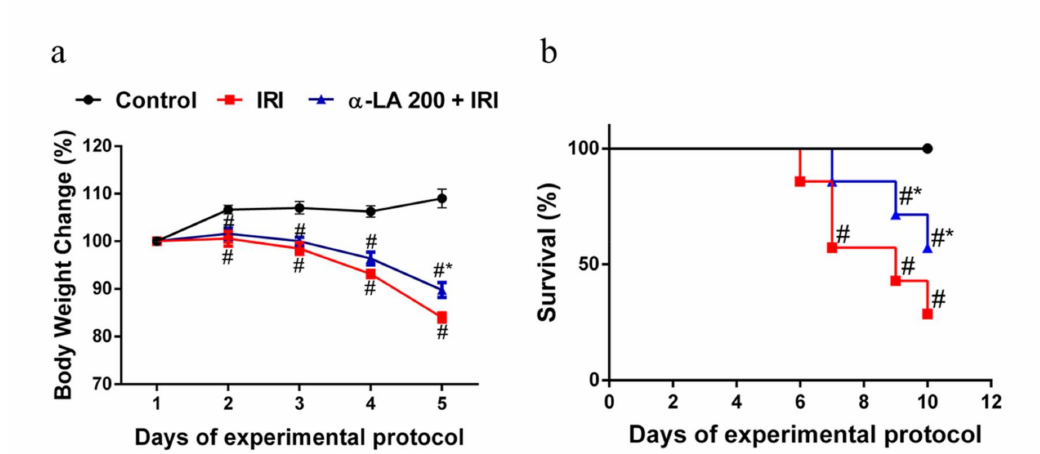
Figure 5. α -LA pretreatment ameliorates the outcomes (body weight loss and survival) of intestinal mucositis induced by irinotecan in mice. ( a ) Body weight was measured daily and is expressed as a percentage of initial body weight. The results are expressed as the mean ± SEM ( n = 6 per group). # represents p < 0.05 versus the control group, and * indicates p < 0.05 versus the IRI group. Two-way ANOVA followed by Bonferroni’s test. ( b ) The survival curve represents the percentage of animals alive at the indicated time point after the first irinotecan dose. The mouse survival rate was evaluated using Kaplan–Meier curves. # represents p < 0.05 versus the control group, and * indicates p < 0.05 versus the IRI group. One-way ANOVA, Mantel–Cox-rank